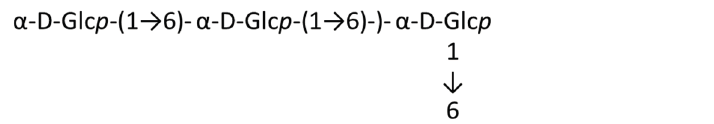
Figure 17. ASLP ( 83 ) isolated from Lischke Arca subcrenata